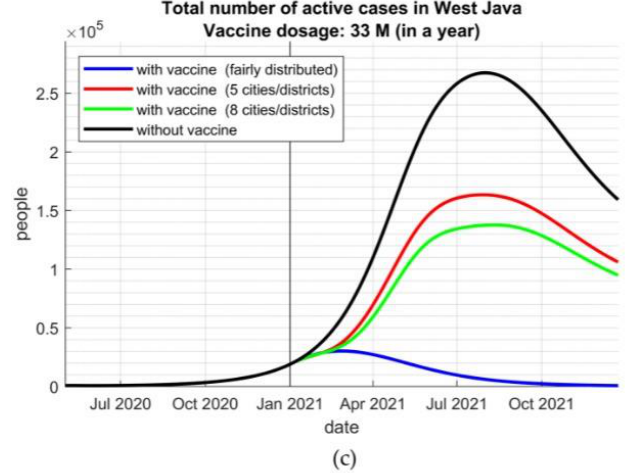
Figure 3. The number of active cases with several scenarios of vaccine distribution given ( a ) the severely lacking vaccines—97,080 dosages in the first four months, ( b ) 300,000 dosages in one year, and ( c ) the optimum available vaccines— 33,000,000 dosages in one year.